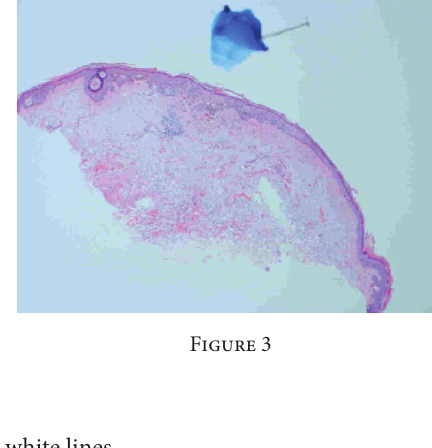
(7) white lines, (8) parallel lines on